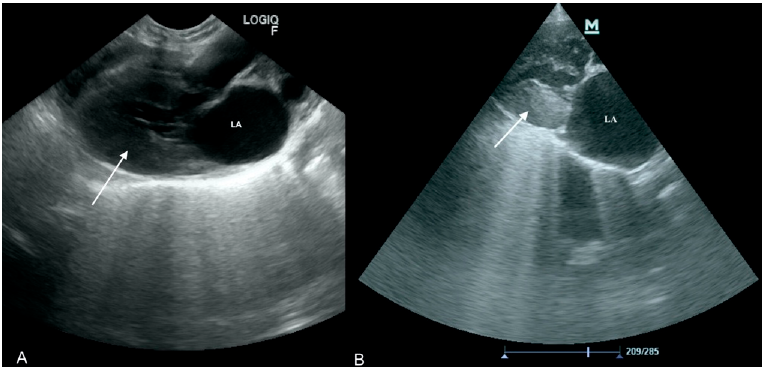
Figure 5. ( A ) White arrow points to the thickened left ventricle free wall, LA—left atrium. ( A ) Scan